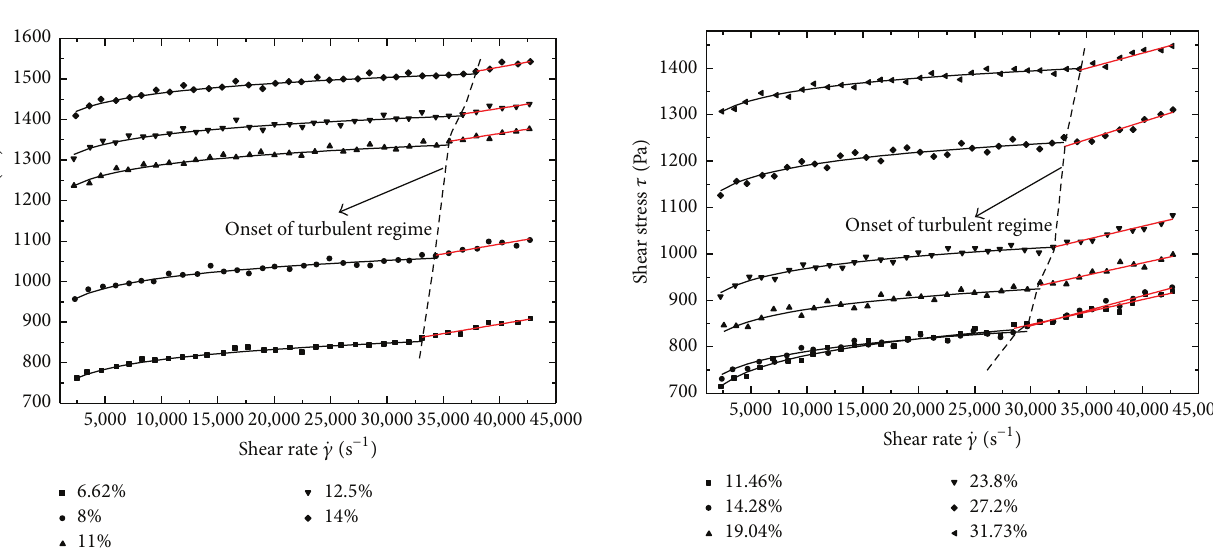
Figure 4: Shear stress versus shear rate of unbleached kraft pulp and several mass concentrations. Table 4: Herschel-Bulkley constants for unbleached kraft pulp suspensions as a function of the fiber mass